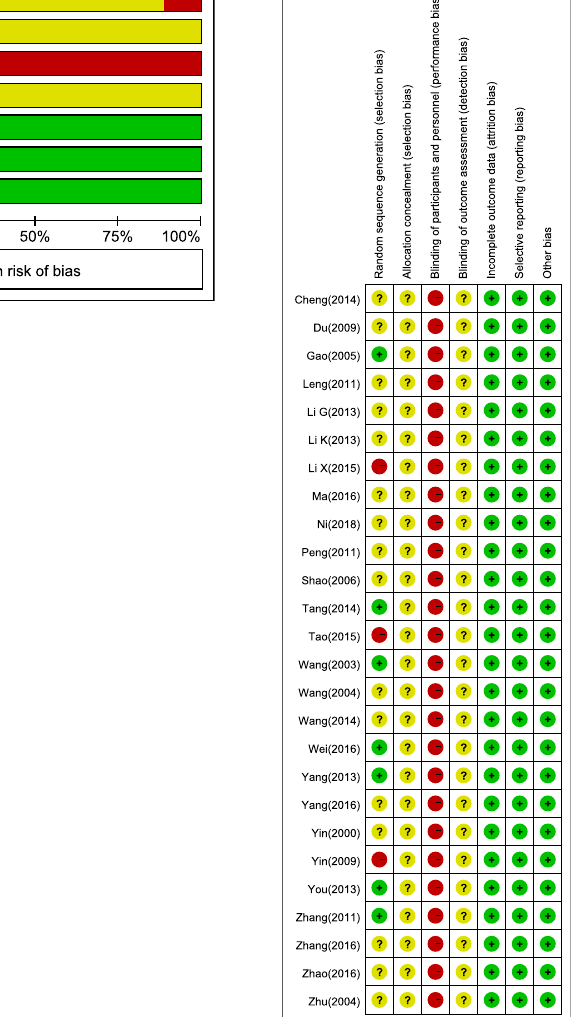
Fig. 2 Risk of bias graph: ( a ) risk of bias of all included studies; ( b ) Risk of bias